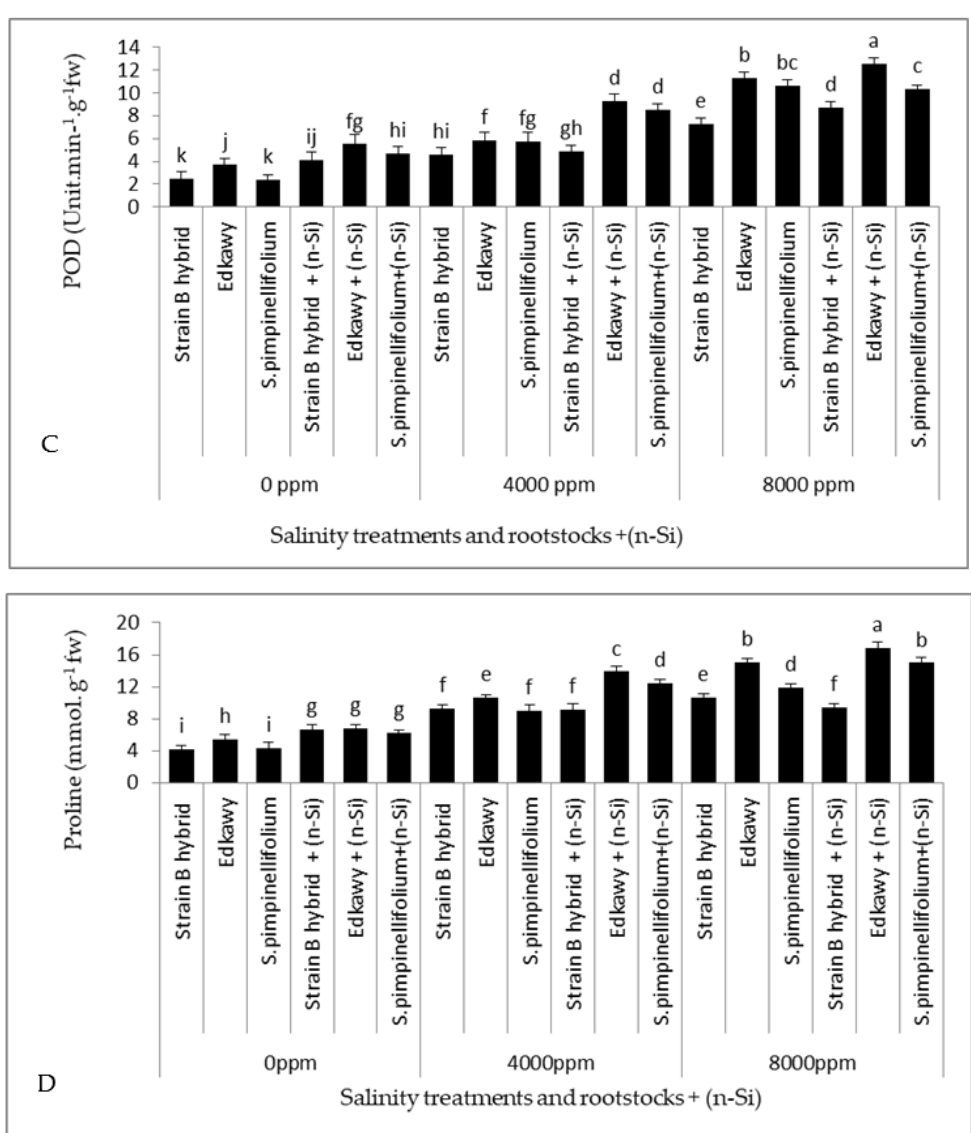
Figure 4. Effect of water salinity levels × rootstocks and foliar spray with (n-Si) and their interactions on ( A ) GA 3 , ( B ) ABA, ( C ) POD, and ( D ) proline. Vertical bars represent standard errors of the means; in each bar, values followed by different letters differ significantly at p = 0.05 according to the LSD